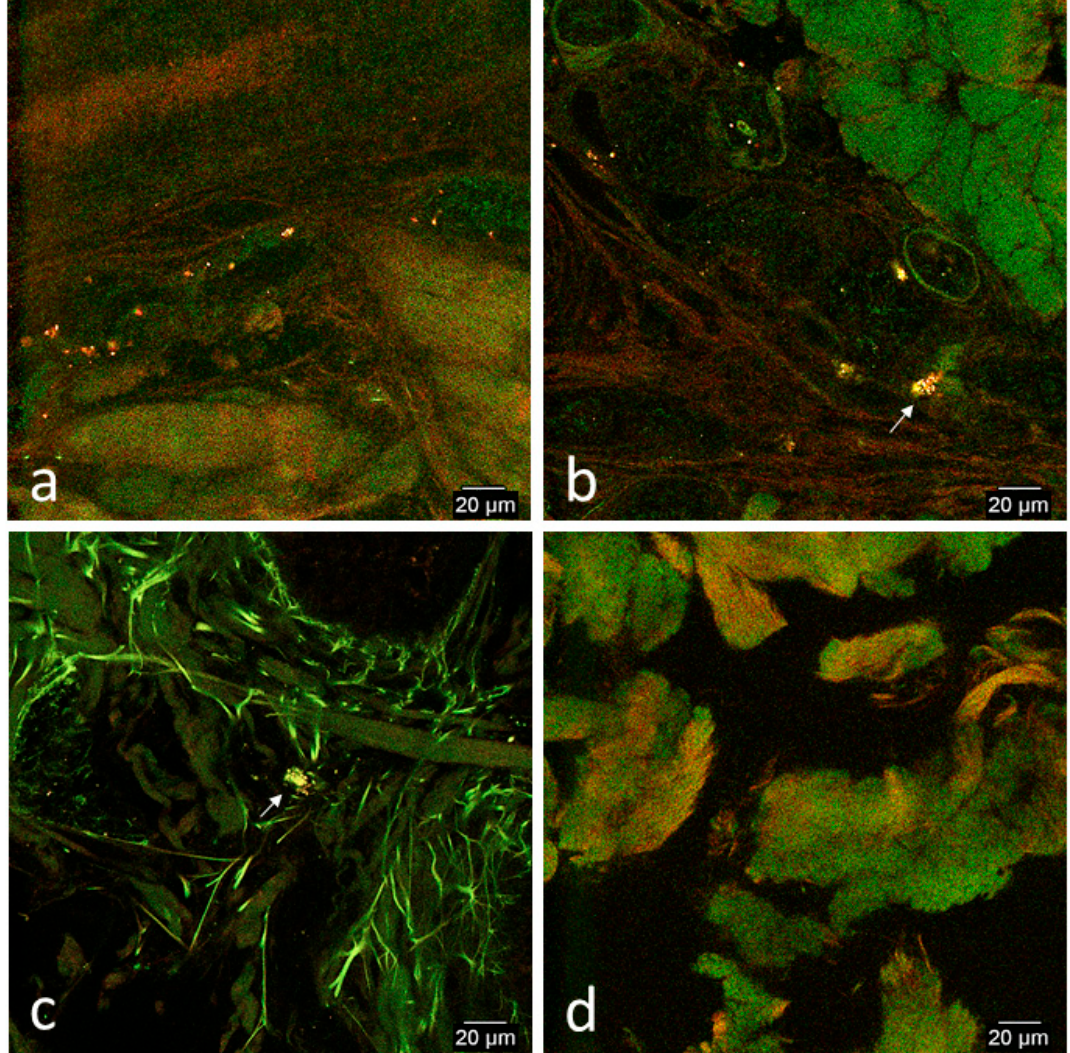
Figure 7. Representative confocal microscopy images of biopsies of limb and thoracic wounds and contralateral non-wounded skin on day 14. ( a ) Wounded limb, ( b ) non-wounded limb, ( c ) wounded thorax, and ( d ) non-wounded thorax. Images were selected from either horse based on best representation of patterns typical fluorescent signal patterns of both horses. Images have been selectively enhanced for purposes of demonstrating signal variation. In both horses, there was no difference in amount of distribution of red or green signal. Signal was often colocalized in small clumps and located within or just adjacent to the vasculature ( a ). A single cell-like structure consistent with in vitro CB-MSCs were detected in the interstitium of the non-wounded limb of horse 1 (arrow, b ) and wounded thorax of horse 2 (arrow, c ). Background auto-fluorescence was more common in all biopsies and is shown in ( d ).